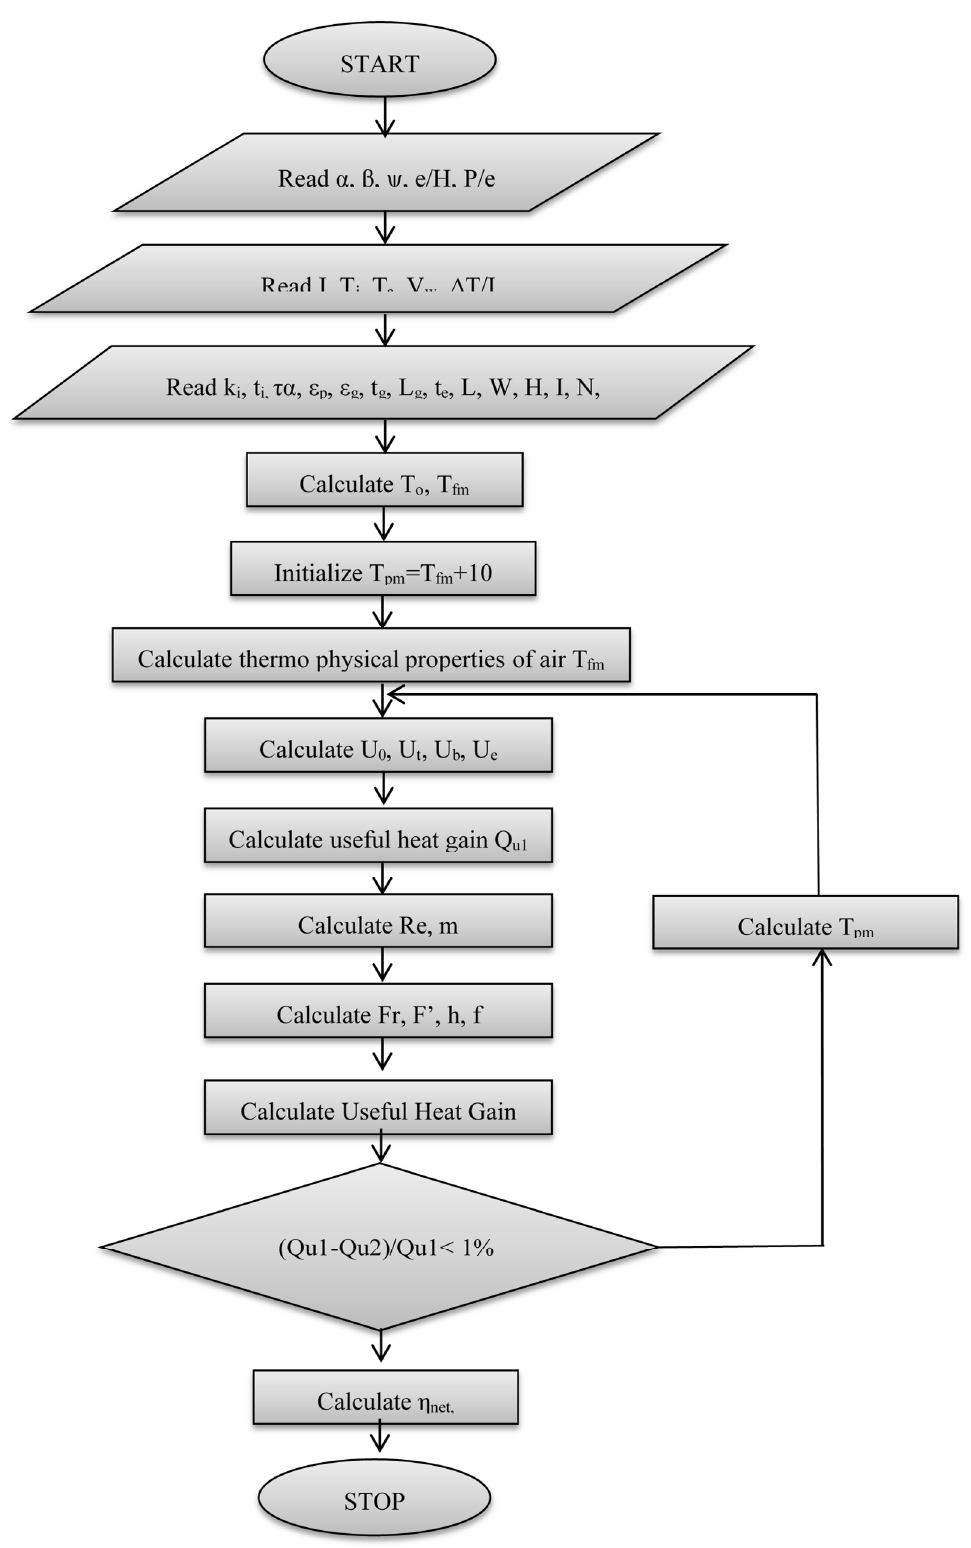
Figure 4. Flow Figure 4. Flow chart